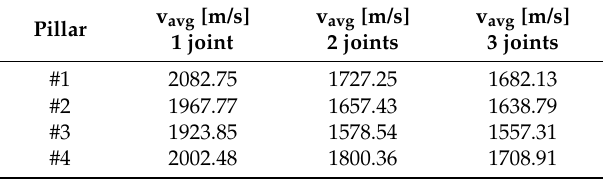
Table 7. The influence of the number of joints on the experimental wave propagation